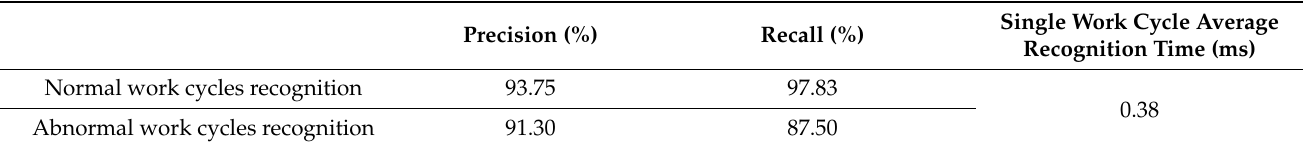
Table 3. Performance of work cycles